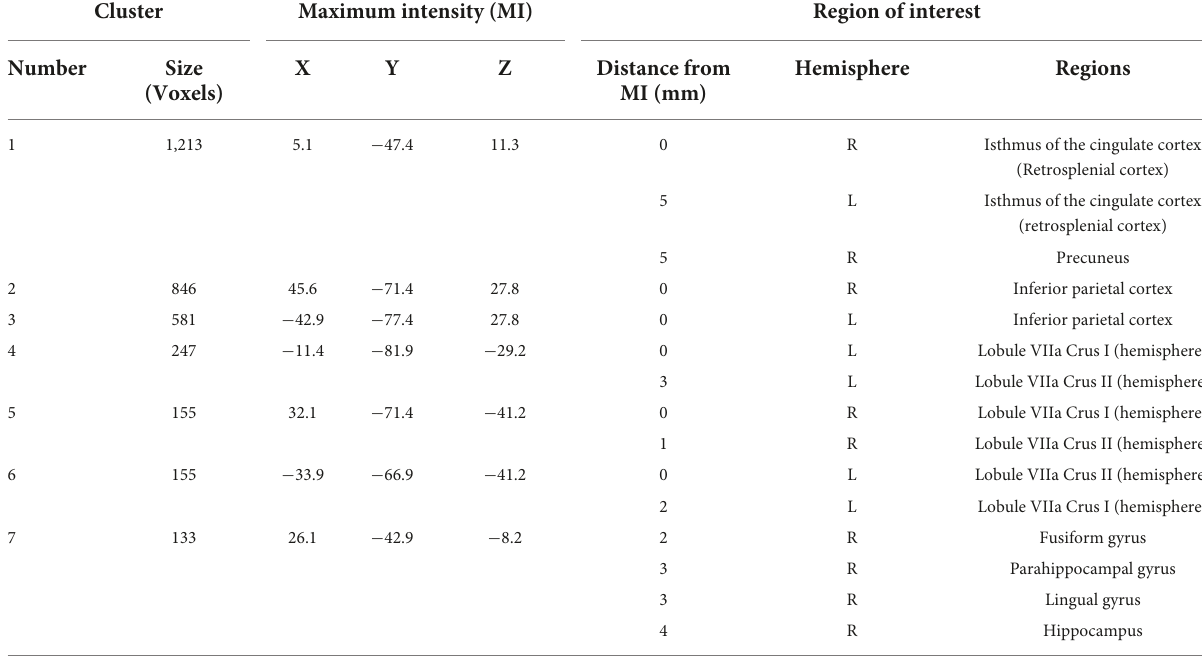
TABLE 2 Clusters that demonstrated significantly greater brain activation ( p < 0.001) in the encoding condition compared to the control condition (encoding > control) that are 100 voxels or greater in size. Cluster Maximum intensity (MI) Region of